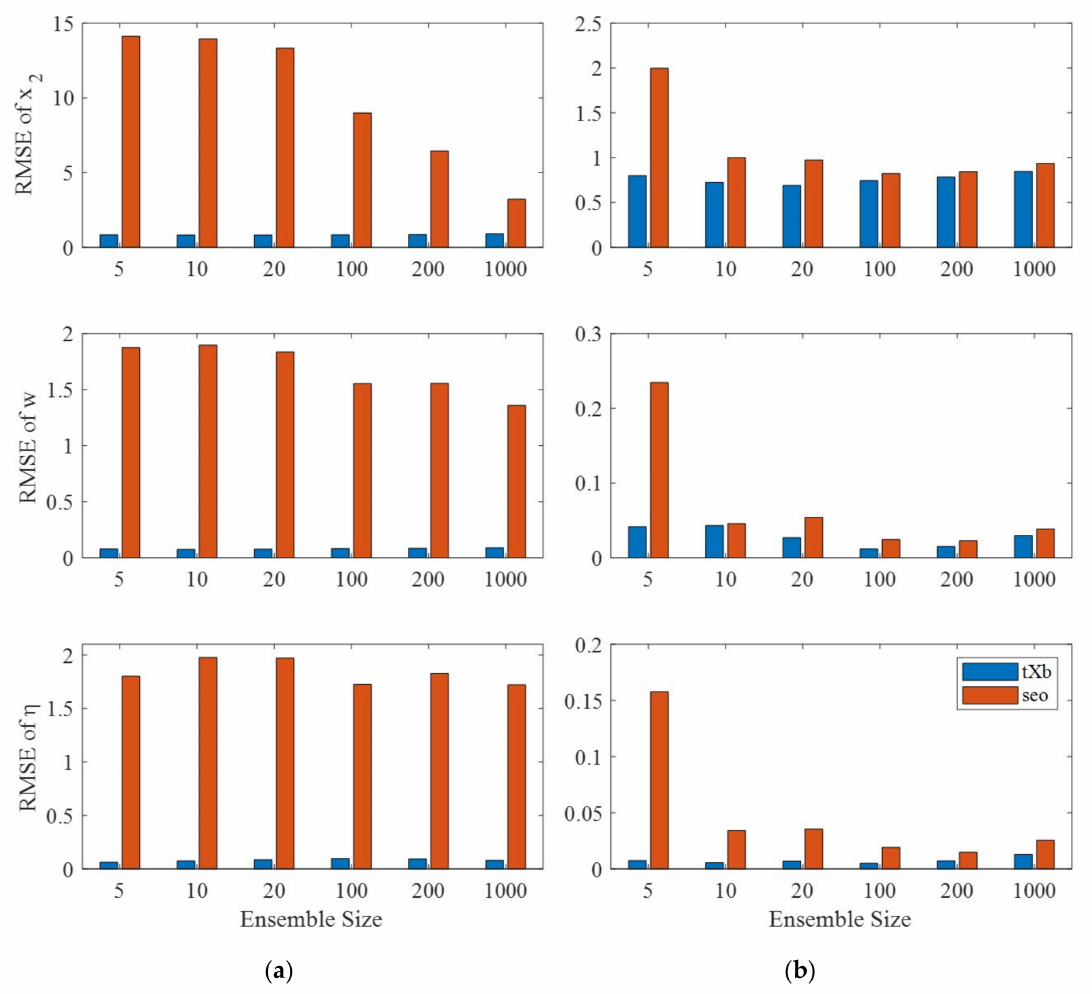
Figure 7. Mean RMSE in the last 5000 TUs of x 2 , ω and η for tXb (blue bar) and SEO (orange bar) with different ensemble sizes, using the imperfect model for ( a ) and the perfect model for ( b